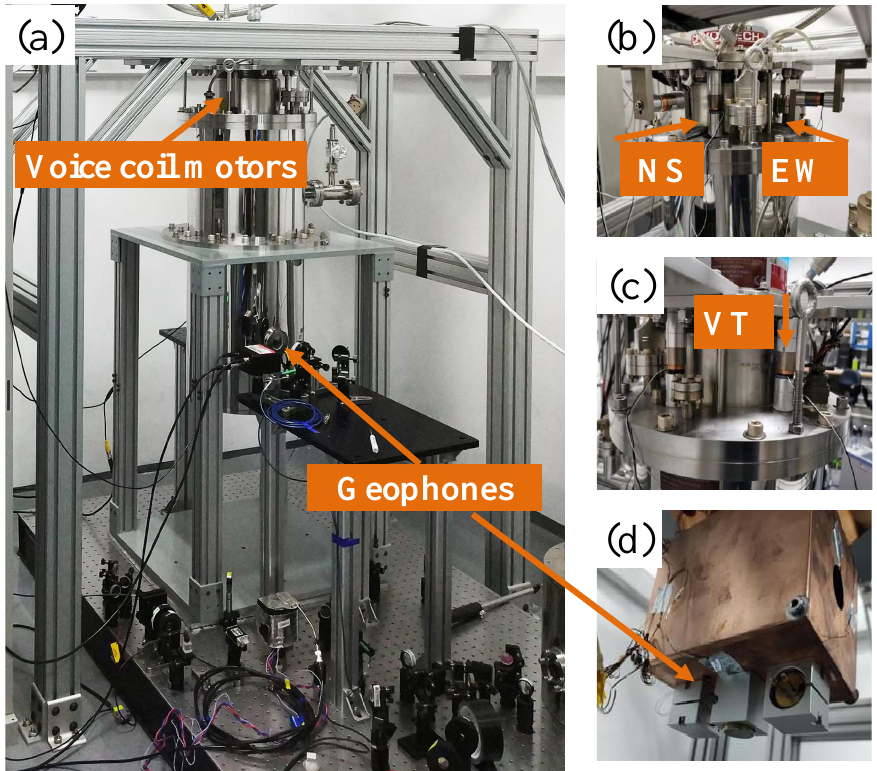
Figure 4. Photo of cryocooler with the vibration excitation and measurement setup. ( a ) The cryocooler. ( b , c ) Pictures of voice coil motors on the cryocooler. ( d ) Three geophone sensors for different directions sensing are fixed to the cryogenic